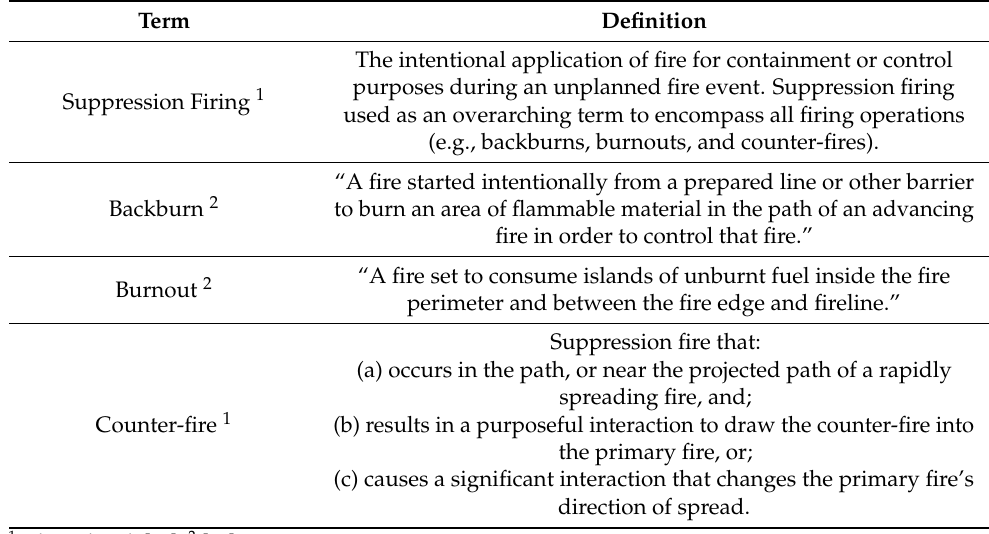
Table 1. Suppression firing